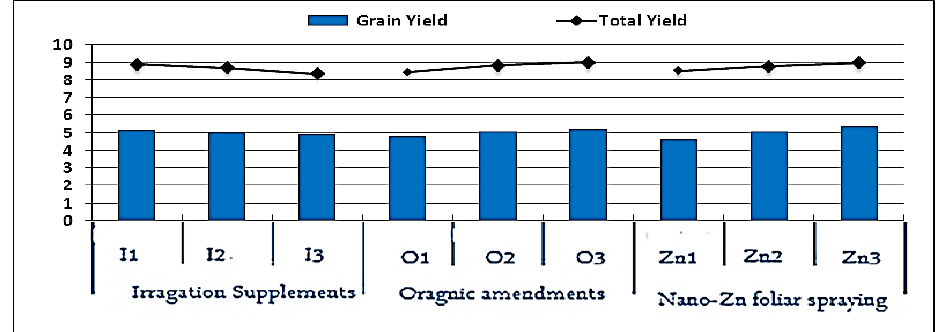
Figure 3. Effect of different organic amendments and nano-Zn foliar spraying concentrations under irrigation supplements on some barley grain and biological yield across the two growing seasons 2018/19 and